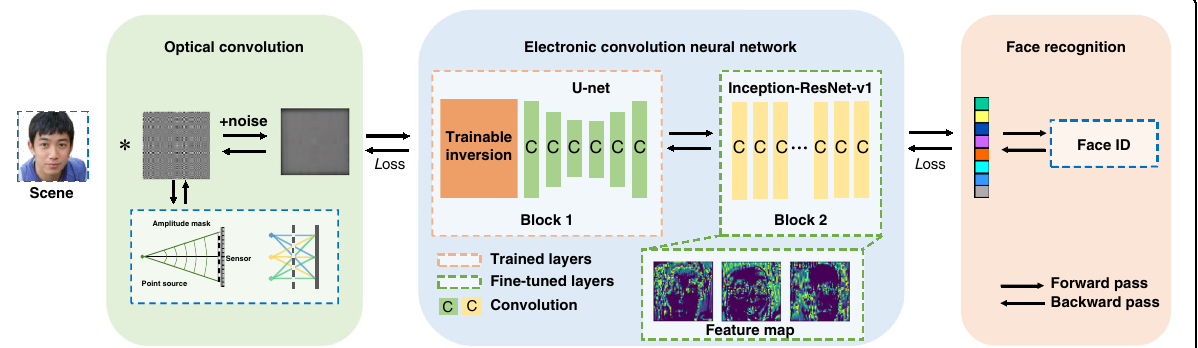
Fig. 8 Proposed end-to-end framework for privacy-protecting face recognition. The optical part consists of a sensor and an amplitude mask to achieve encryption by optical convolution. The electrical part consists of two blocks to extract features. We achieve face recognition by jointly optimizing the optics and training the electronic convolution neural